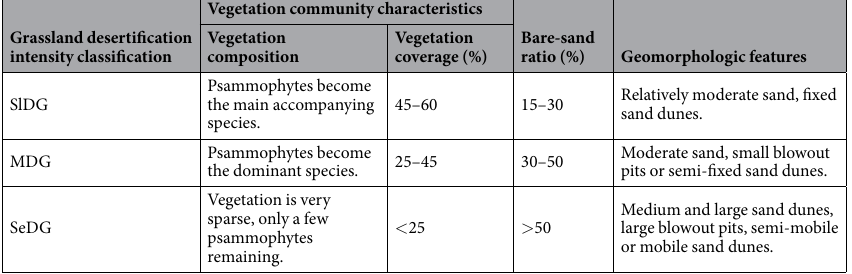
Table 4. Remote sensing grading system of grassland desertification in